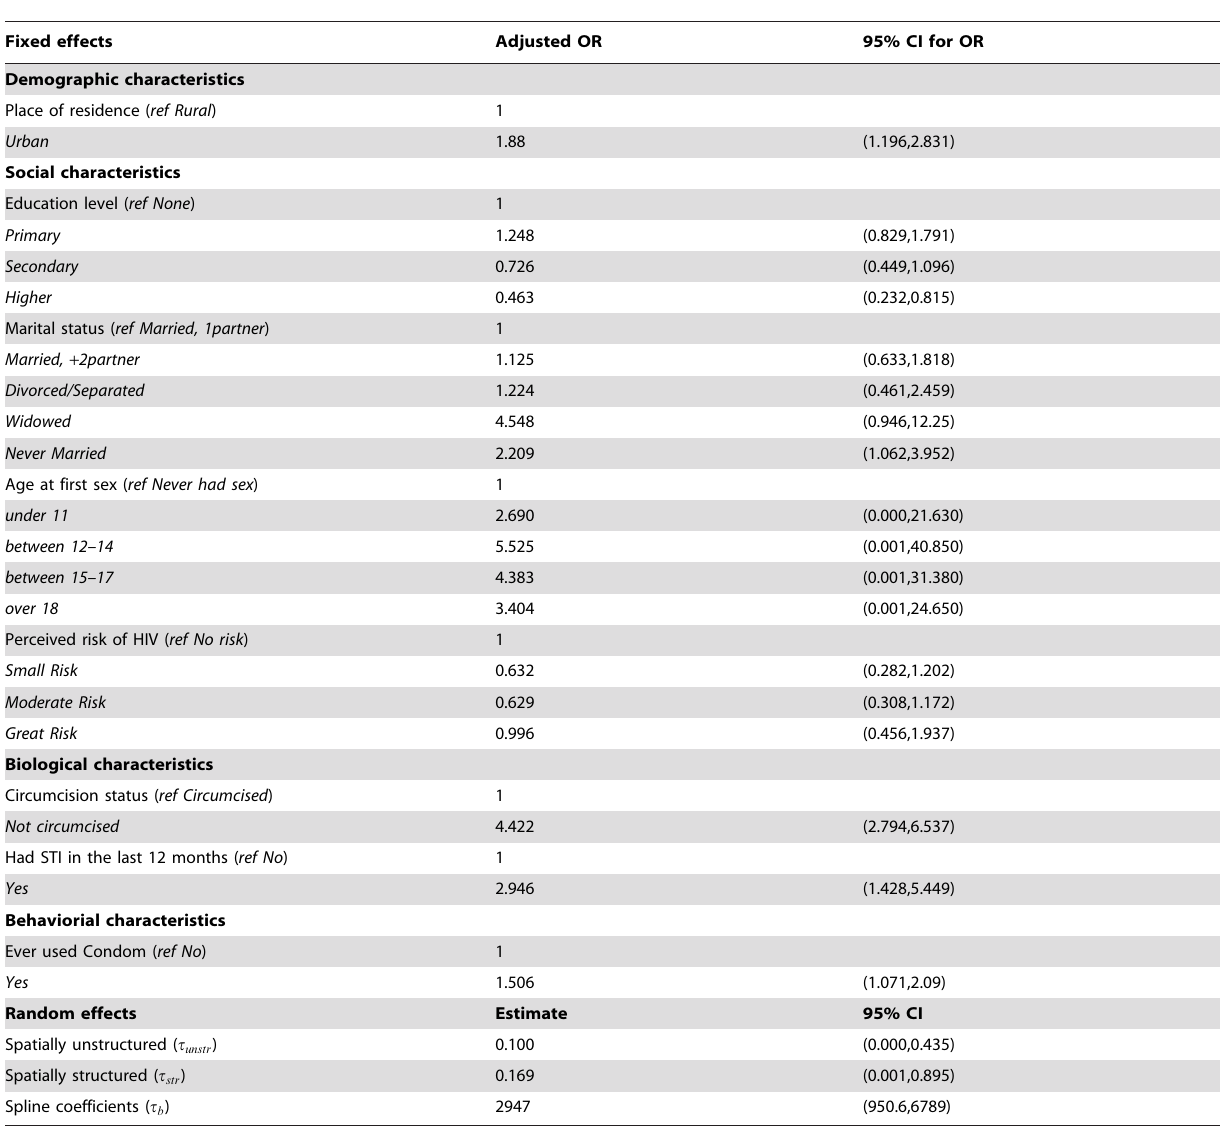
Table 4. Parameter estimates based on the best fitting model